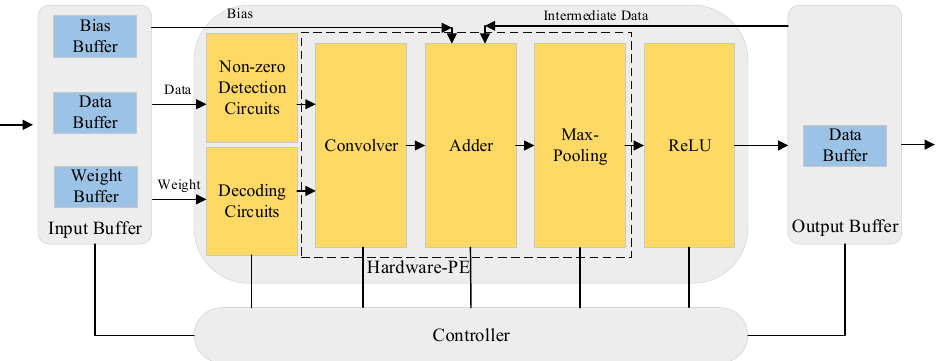
Figure 9. The hardware-PE. ReLU: rectified linear